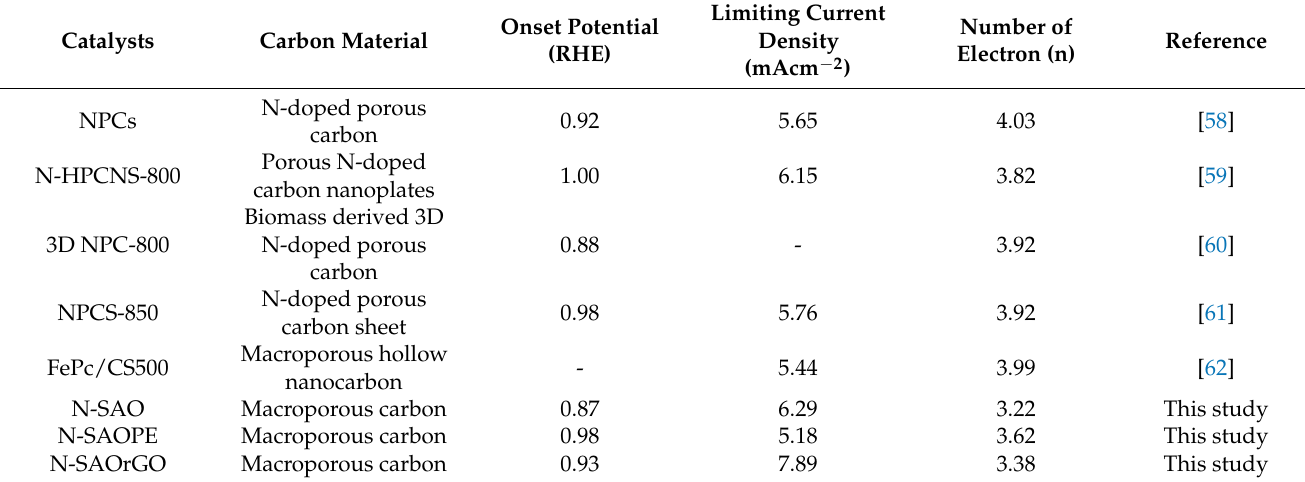
Table 4. Comparison of the catalysts with similar MCM